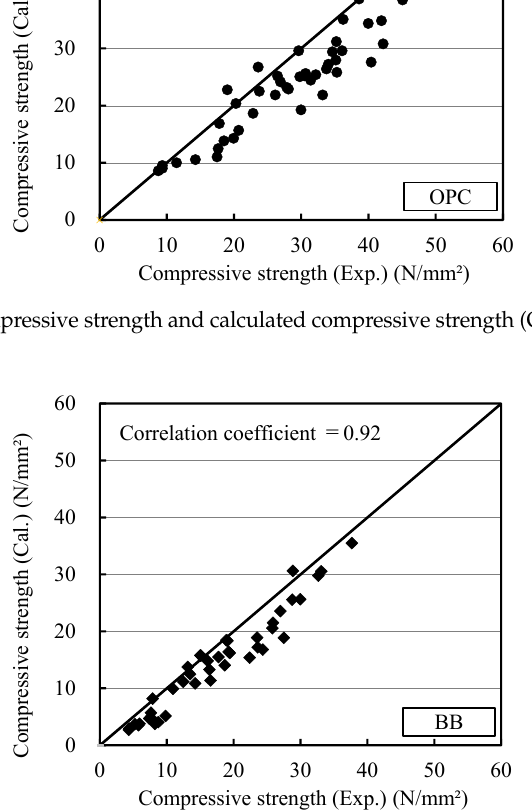
Figure 6. Measured compressive strength and calculated compressive strength (BB): Previous equation for maturity.